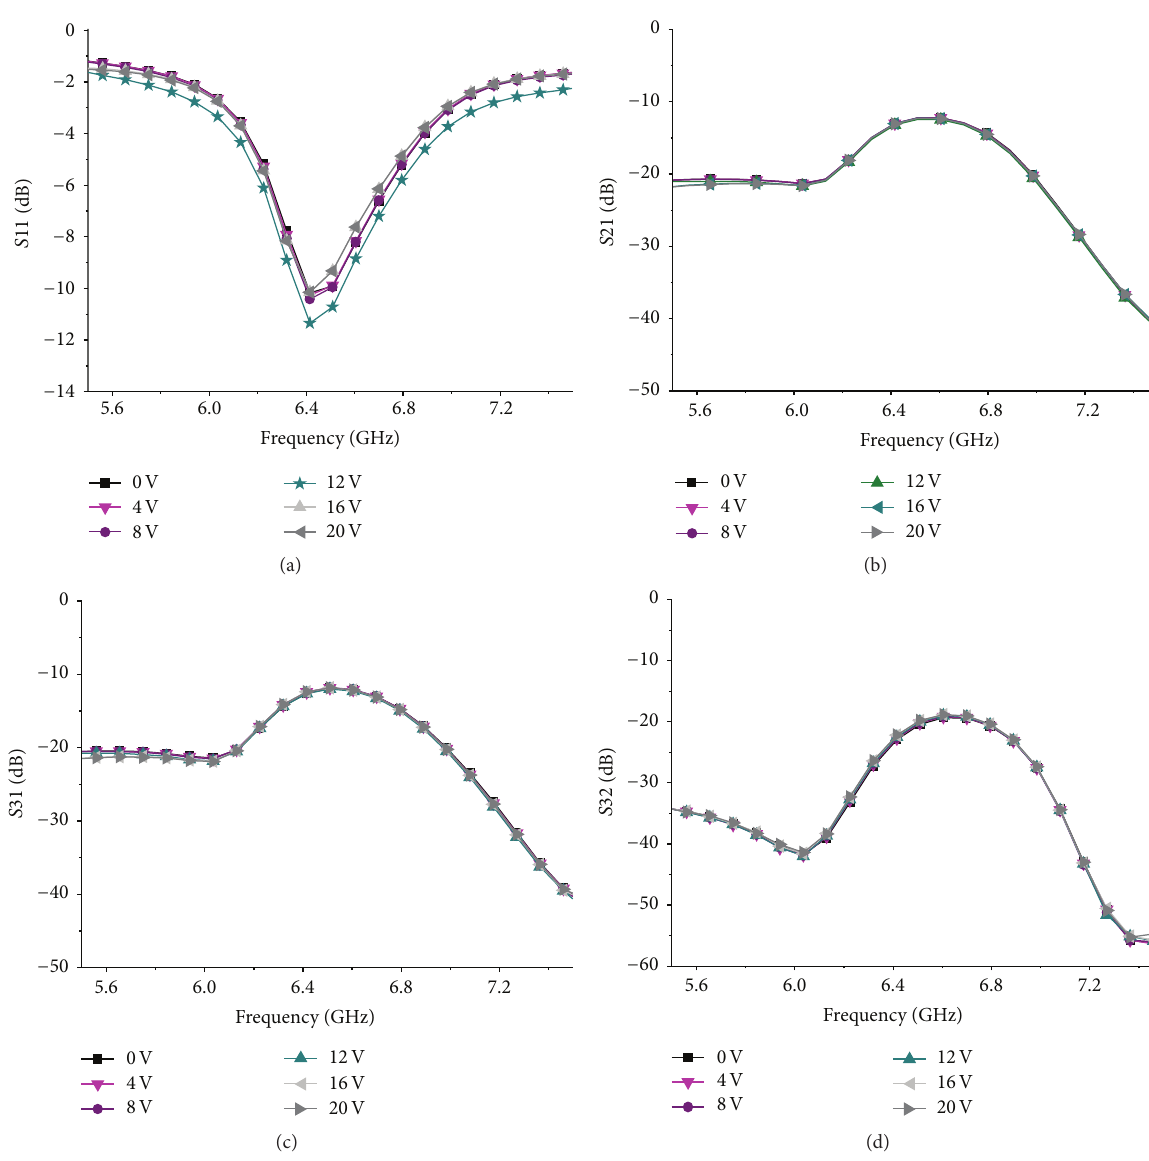
Figure 9: Measured frequency response under application of various peak voltages. (a) S11; (b) S21; (c) S31; (d)